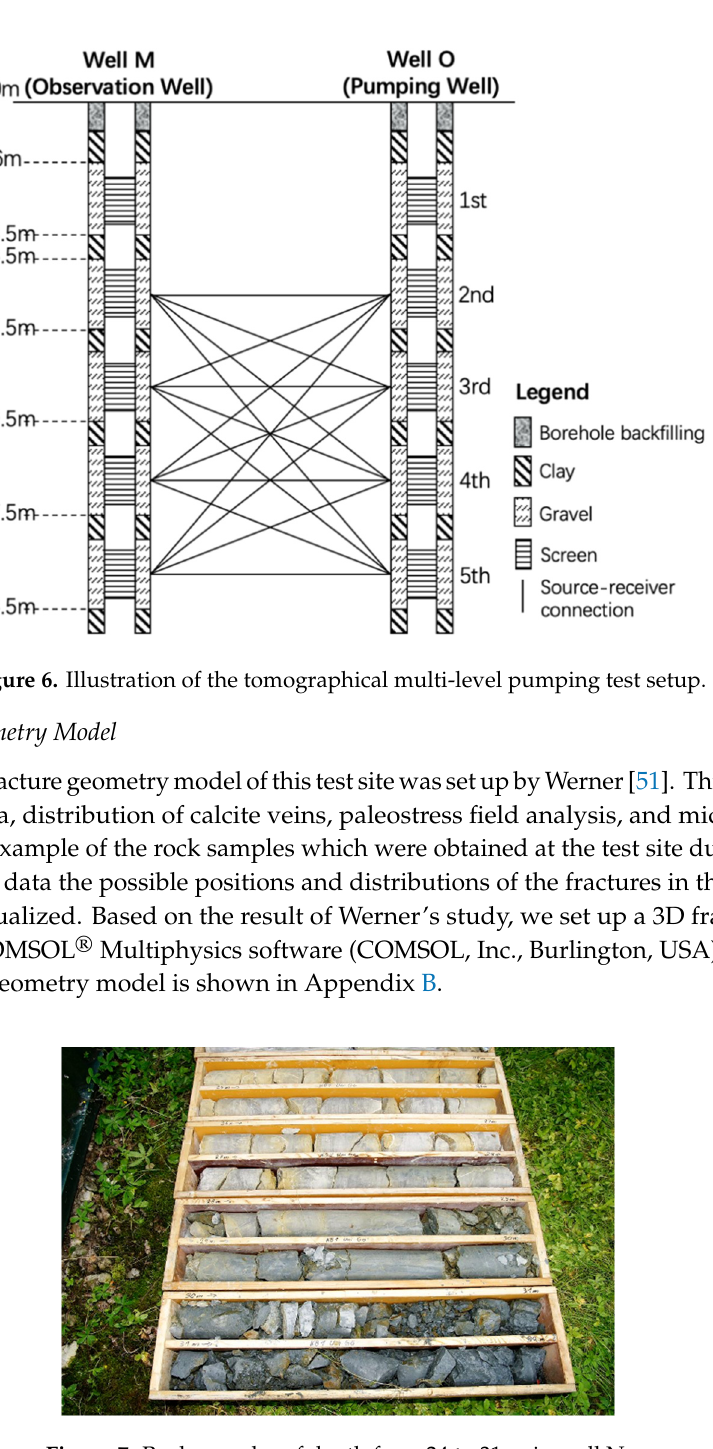
Figure 5. Double packer systems ( a ) within the pumping well and ( b ) within the observation well. Following a tomographic configuration, the multi-level pumping tests were conducted in a sequential manner by positioning the pump packer system at a certain well screen and observing subsequently at multiple levels within the observation well. The pump did not work at shallow depth (i.e., at the first screen of the pumping well O) because of the relatively low hydraulic conductivity. Therefore, the pumping tests were conducted starting from the second screen to the fifth well screen. The second to the fifth screens of pumping well O were acting as source points, while the second to the fifth screens of observation well M were acting as receiving points in the tests (compare Figure